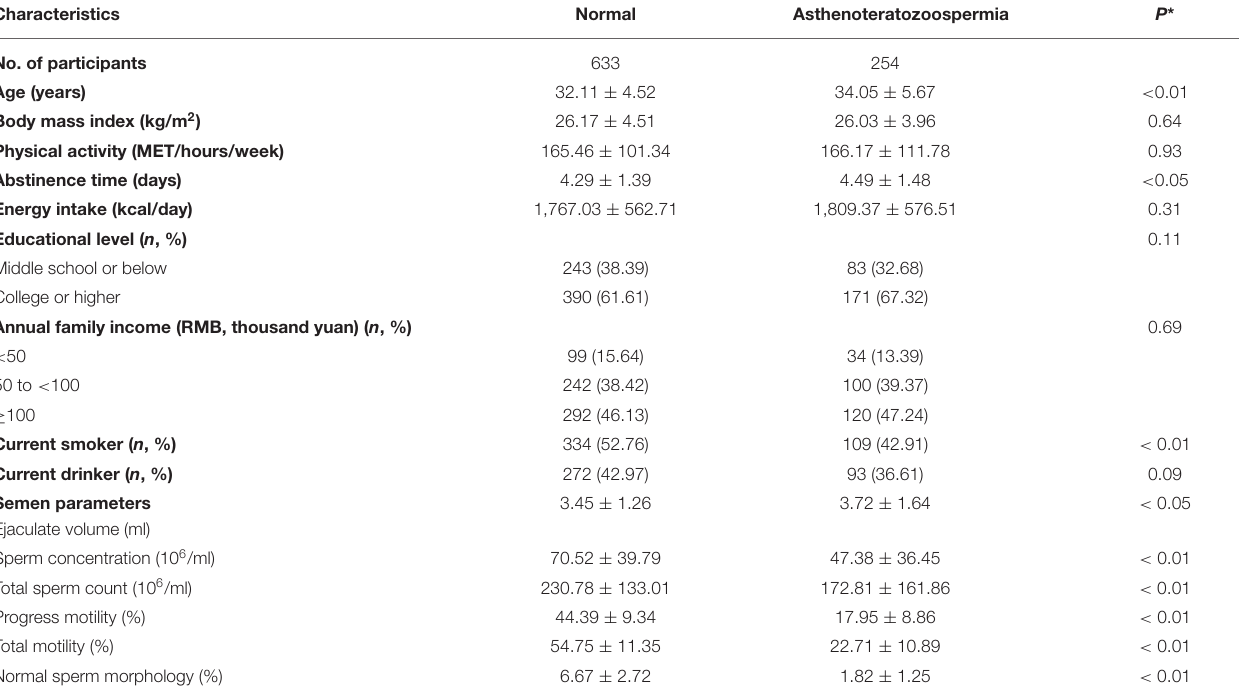
TABLE 1 | General characteristics of participants in a case-control study of